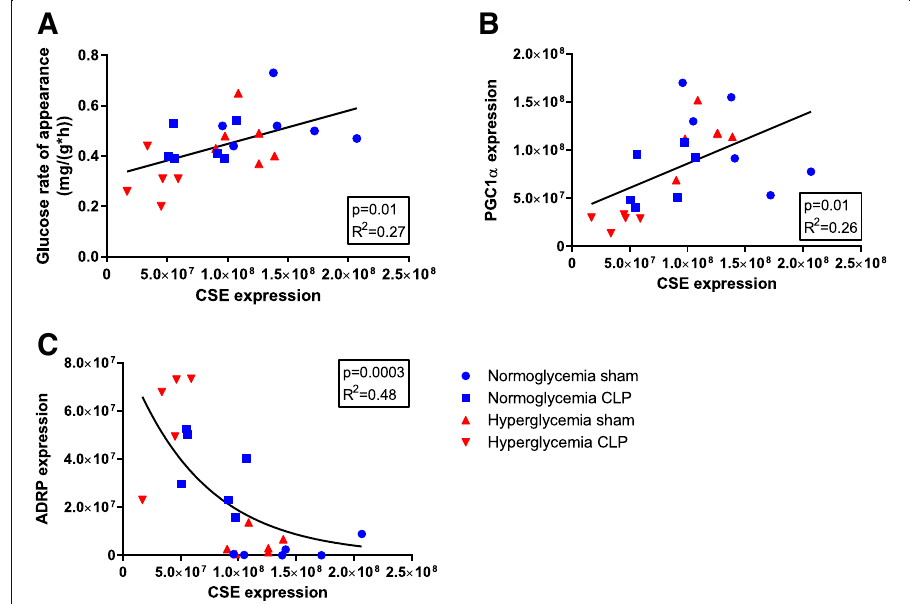
Fig. 5 Glucose rate of appearance ( a ), peroxisome proliferator-activated receptor gamma coactivator 1-alpha (PGC1 α ) ( b ) and adipocyte differentiation-related protein (ADRP) ( c ) plotted as a function of cystathionine- γ - lyase (CSE) expression, pooled data from all experimental groups. R 2 is the Pearson ’ s coefficient for linear, and Spearman ’ s coefficient for non-linear